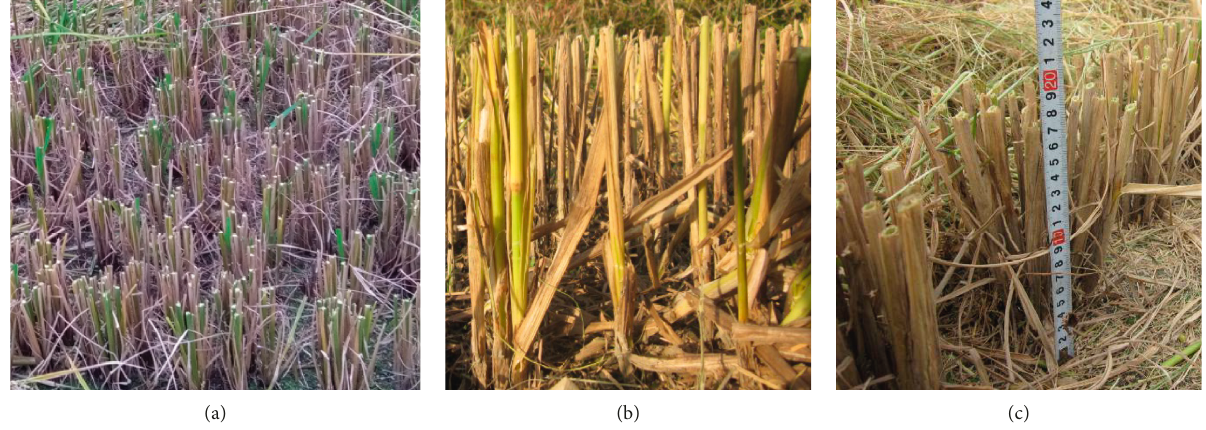
Figure 20: Stem cutting effect at different forward speeds: (a) 0.6m/s, (b) 0.8m/s, and (c)